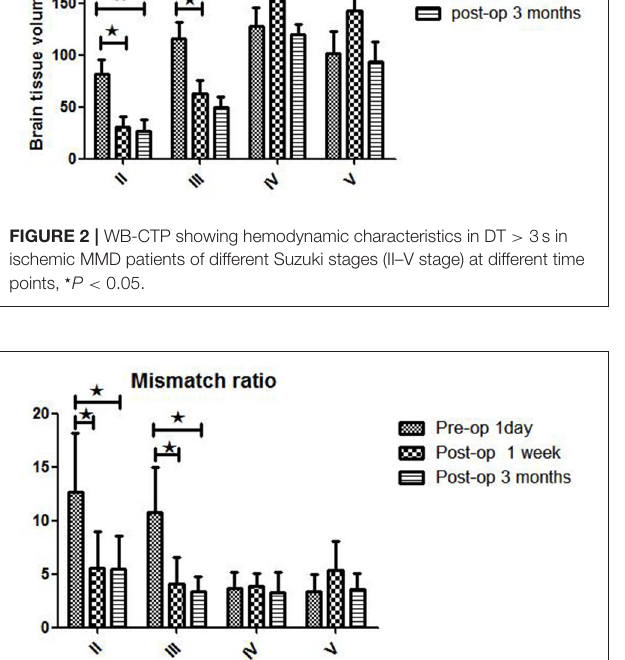
FIGURE 3 | WB-CTP showing hemodynamic characteristics in DT > 3s in ischemic MMD patients of different Suzuki stages (early and later stage) at different time points. Early stage: in Suzuki stage II and III Later stage:in Suzuki stage IV and V. ⋆ P < 0.05.